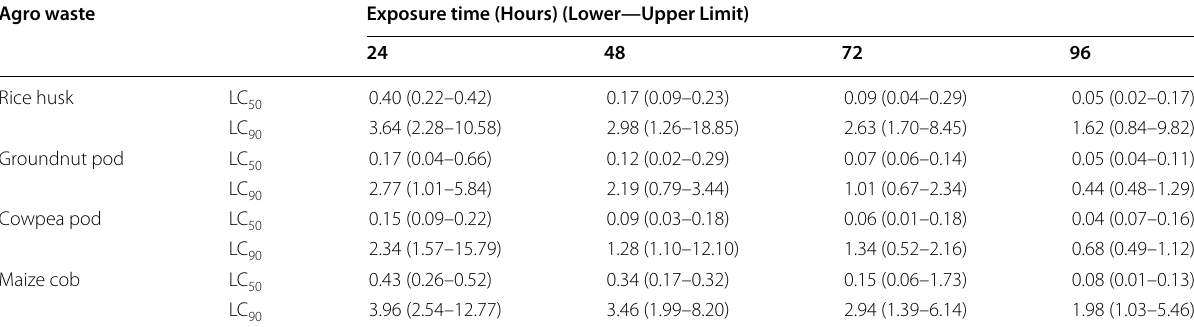
and LC ) of agro-waste extracts against C. 50 90